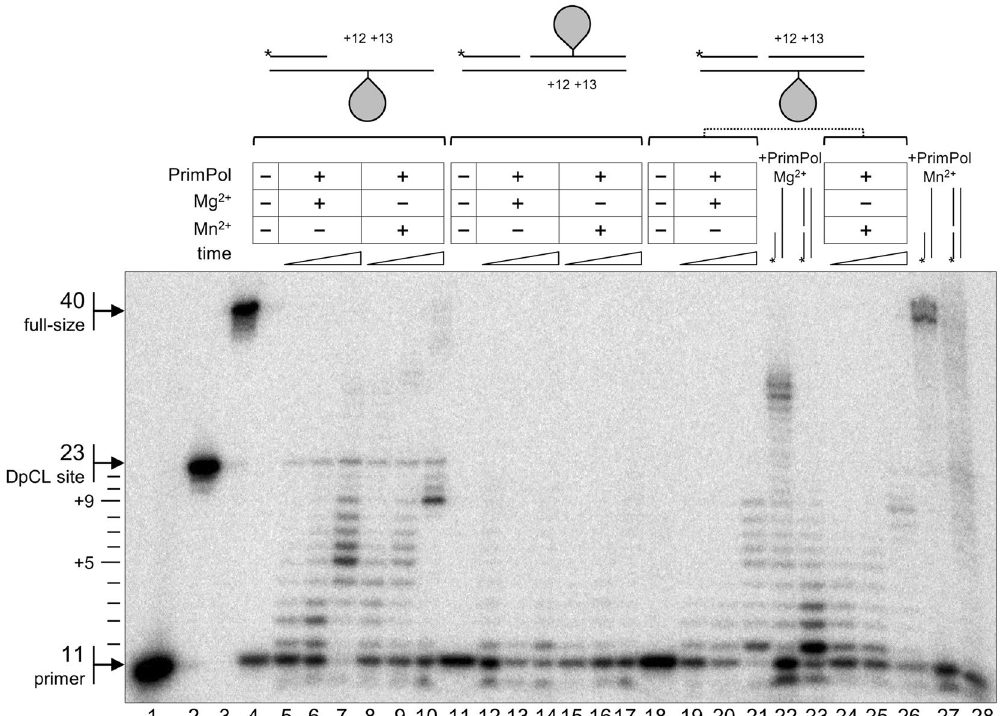
Figure 4. DNA polymerase and strand displacement activities of PrimPol on DNA substrate with a DpCL. Schemes of the DpCL-containing substrates are shown at the top panel. The CL site is located at the + 13 position from the 3 ʹ -OH of the primer. Lanes 1–3 , size markers corresponding to the primer ( lane 1 , 11 nt long), primer extended to the position immediately before the cross-link site ( lane 2 , 23 nt) and full-size product ( lane 3 , 40 nt). Lane 4 , ss-DpCL without PrimPol, lanes 5–7 , ss-DpCL with PrimPol and Mg 2+ , lanes 8–10 , ss-DpCL with PrimPol and Mn 2+ . Lane 11 , down-DpCL without PrimPol, lanes 12–14 , down-DpCL with PrimPol and Mg 2+ , lanes 15–17 , down-DpCL with PrimPol and Mn 2+ . Lane 18 , temp-DpCL without PrimPol, lanes 19–21 , extension time points were 2, 5, and 30 min. In lanes 22 and 27 , the reaction was carried out with an undamaged primer–template substrate in the presence of Mg 2+ ( lane 22 ) or Mn 2+ ( lane 27 ), and in lanes 23 and 28 , with an for 30